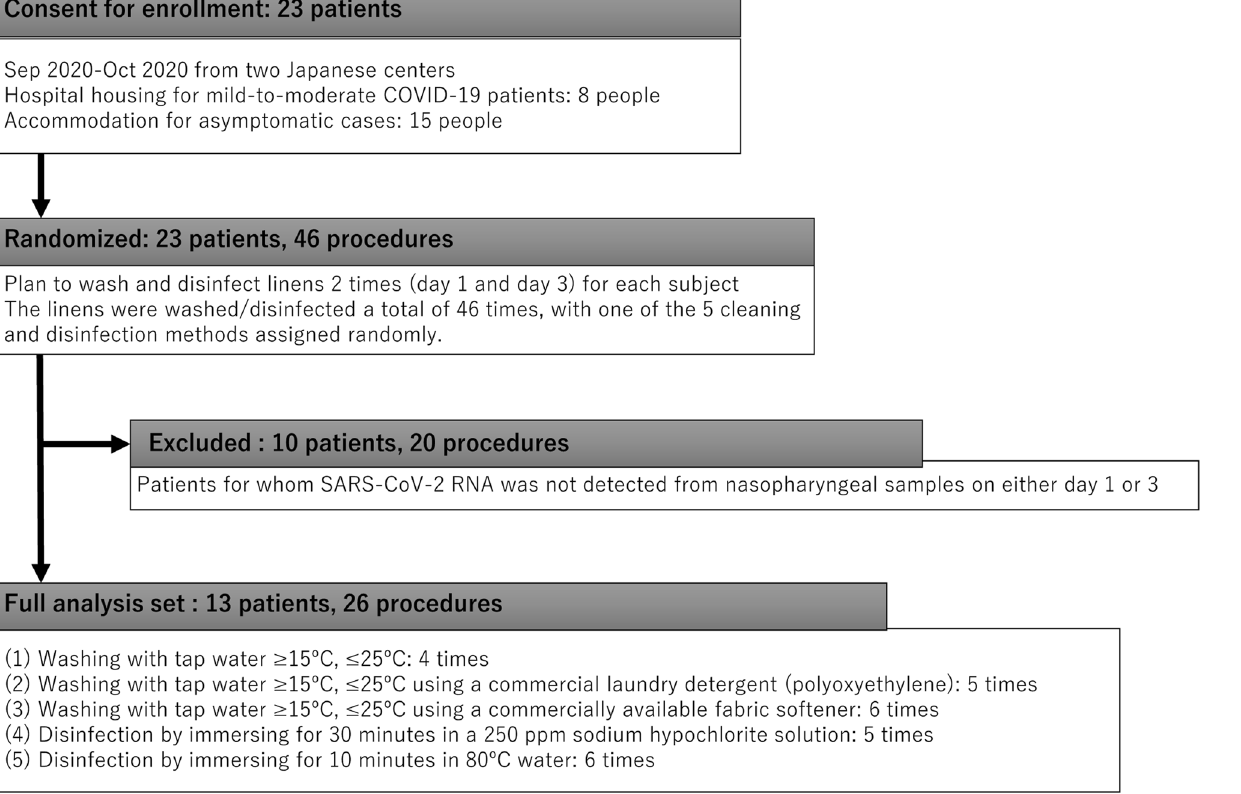
Figure 1. Enrollment, assignment to cleaning or disinfection methods and exclusion of the participants in the